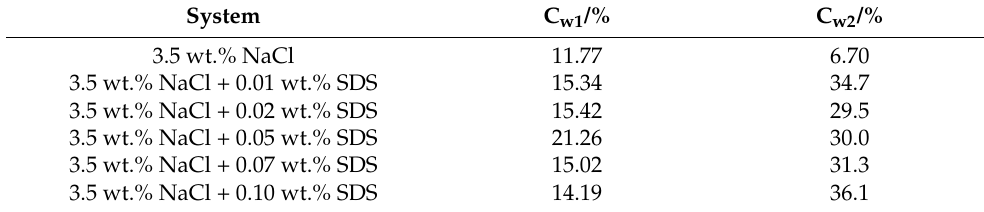
Table 3. Conversion rate of water in macroscopic and microscopic